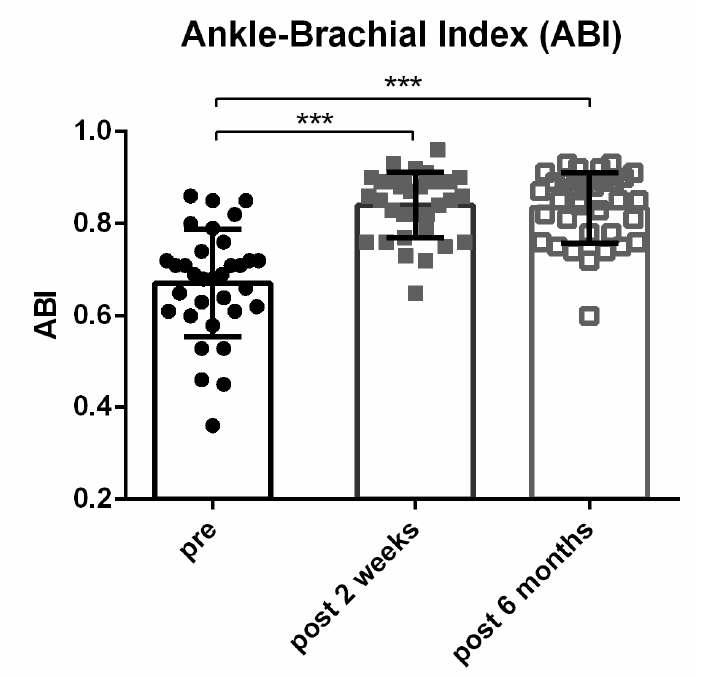
Figure 1. Ankle-Brachial-Index at pre-intervention and at time marks of 2 weeks and 6 months. ABIs were acquired according to ESVS Guidelines (mean ± SD). (*** = p < 0.001).